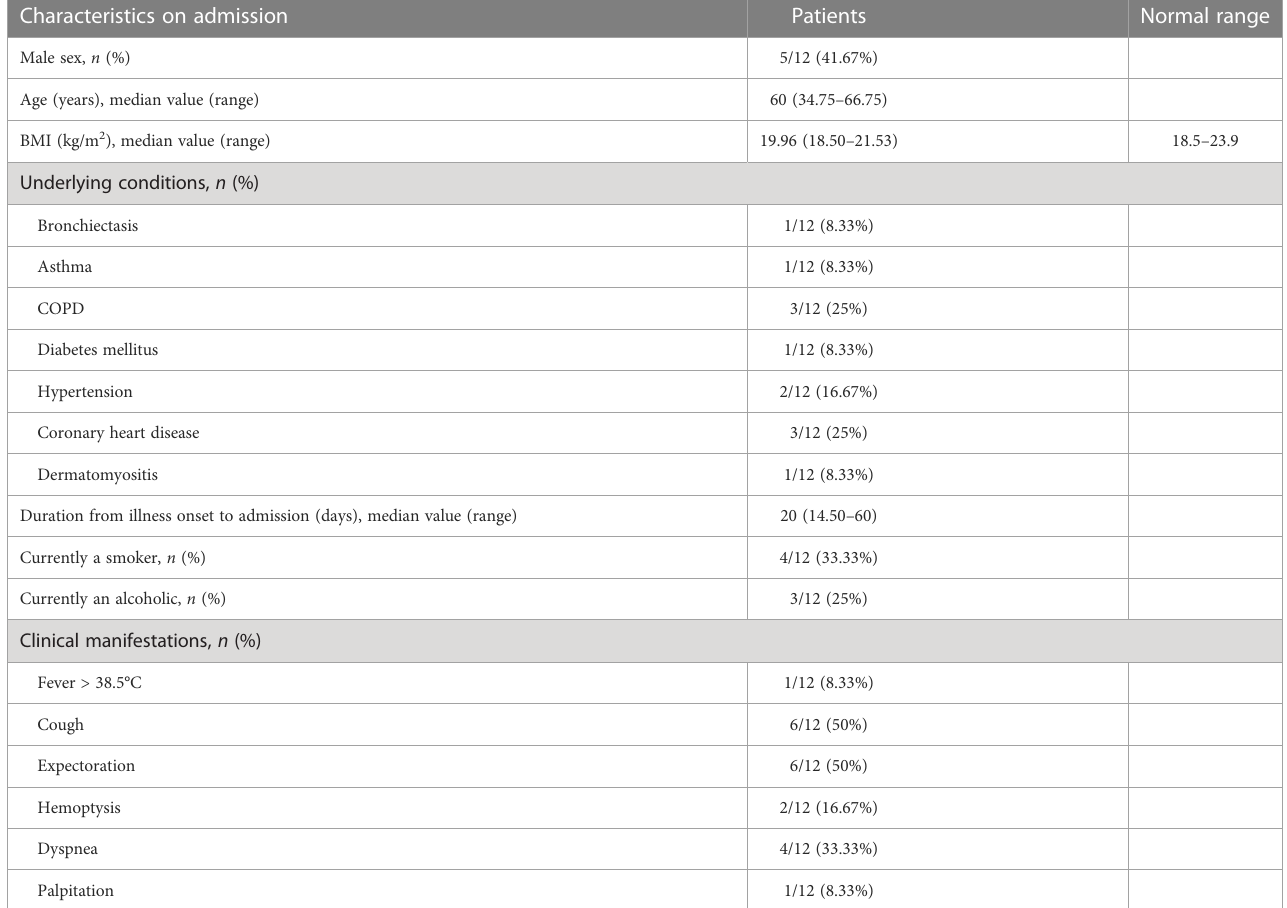
TABLE 2 Baseline characteristics, clinical manifestation, and radiographic fi ndings of patients on admission. Characteristics on